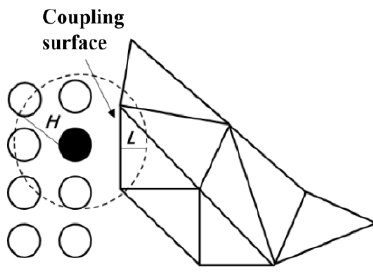
Figure 1. SPH-FEM Coupling surface.